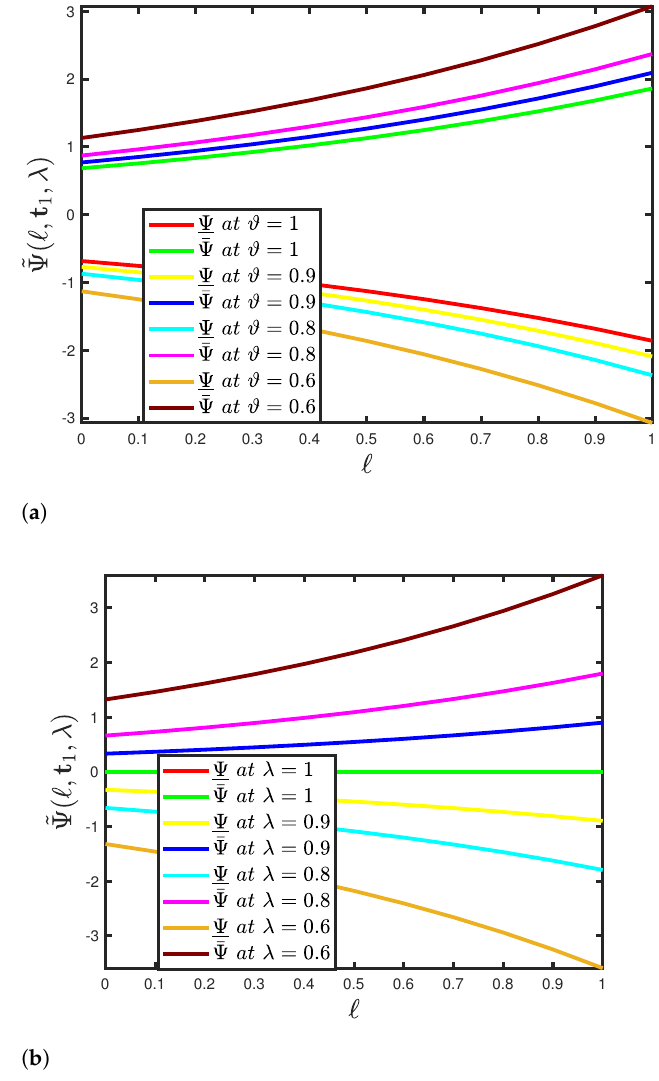
Figure 10. Two-dimensional simulation of ˜ Ψ ( (cid:96) , t 1 ; λ ) of Problem (3): ( a ) Ψ ( (cid:96) , t 1 ; λ ) and ¯ Ψ ( (cid:96) , t 1 ; λ ) when fuzzy CFD is considered to have an uncertainty parameter λ ∈ [ 0,1 ] and t 1 = 0.7; and ( b ) Ψ ( (cid:96) , t ) and ¯ Ψ ( (cid:96) , t ) when fuzzy CFD is considered to have a fractional order ϑ = 0.7 and 1 ; λ 1 ; λ t 1 =